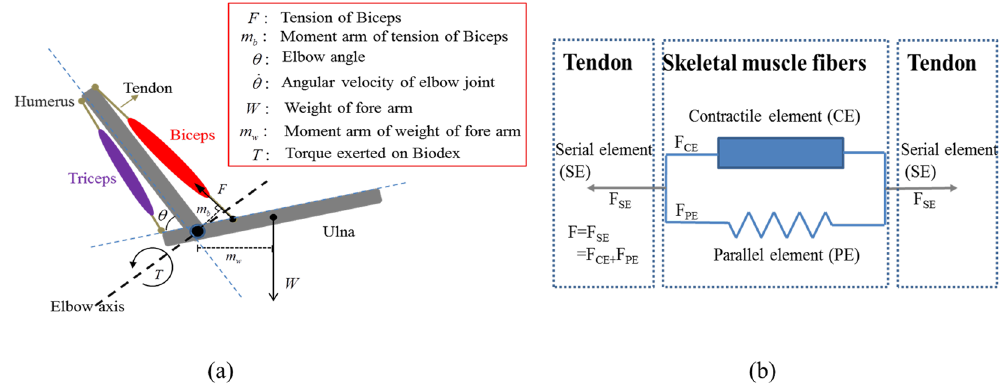
Figure 1. ( a ) Muscular-skeleton model of human elbow. ( b ) 3-elements of a typical skeletal muscle according to Hill 1